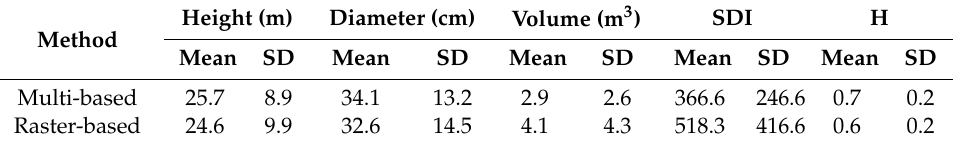
Table 6. ALS-estimated variables using the multisource-based method and raster-based method at forest unit